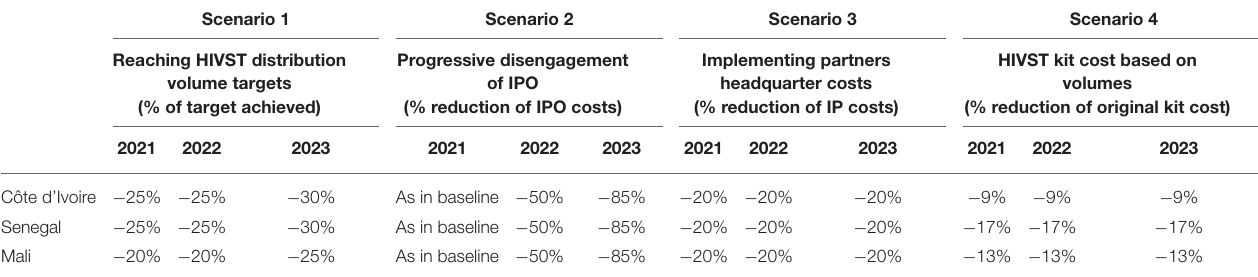
TABLE 3 | Selected parameters for the scenario analysis of costs at scale-up in Côte d’Ivoire, Senegal, and Mali (baseline: all parameters at